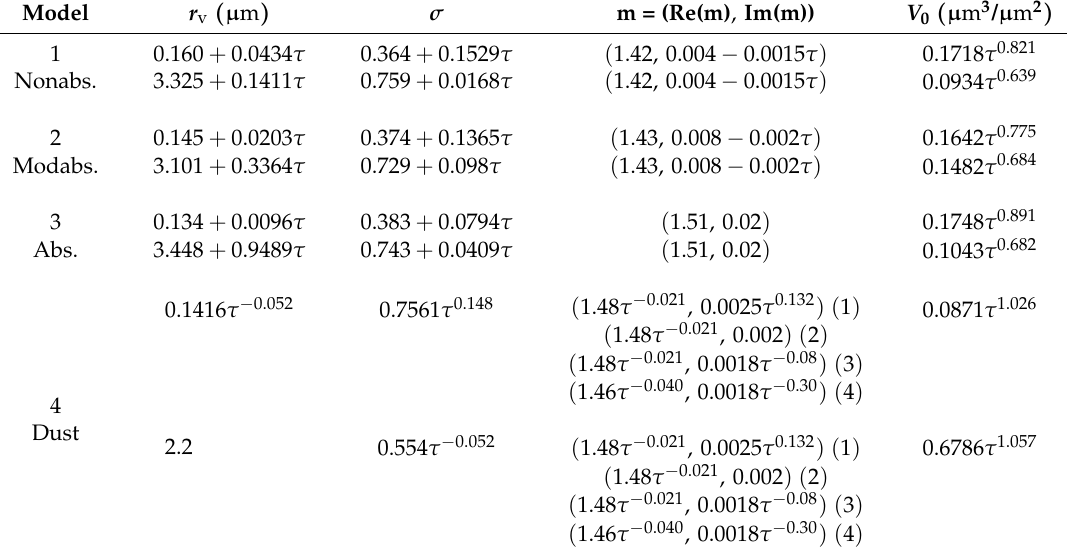
Table 1. Optical properties of the aerosol models. For each model, the first and second lines are related to the accumulated and coarse modes, respectively. The complex refractive index of dust corresponds to the wavelengths 470 (1), 550 (2), 660 (3), and 2100 (4) nm. In the simulations, the values of the refractive index at λ = 660 nm are